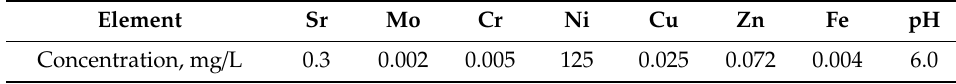
Table 2. Chemical composition of industrial e ffl